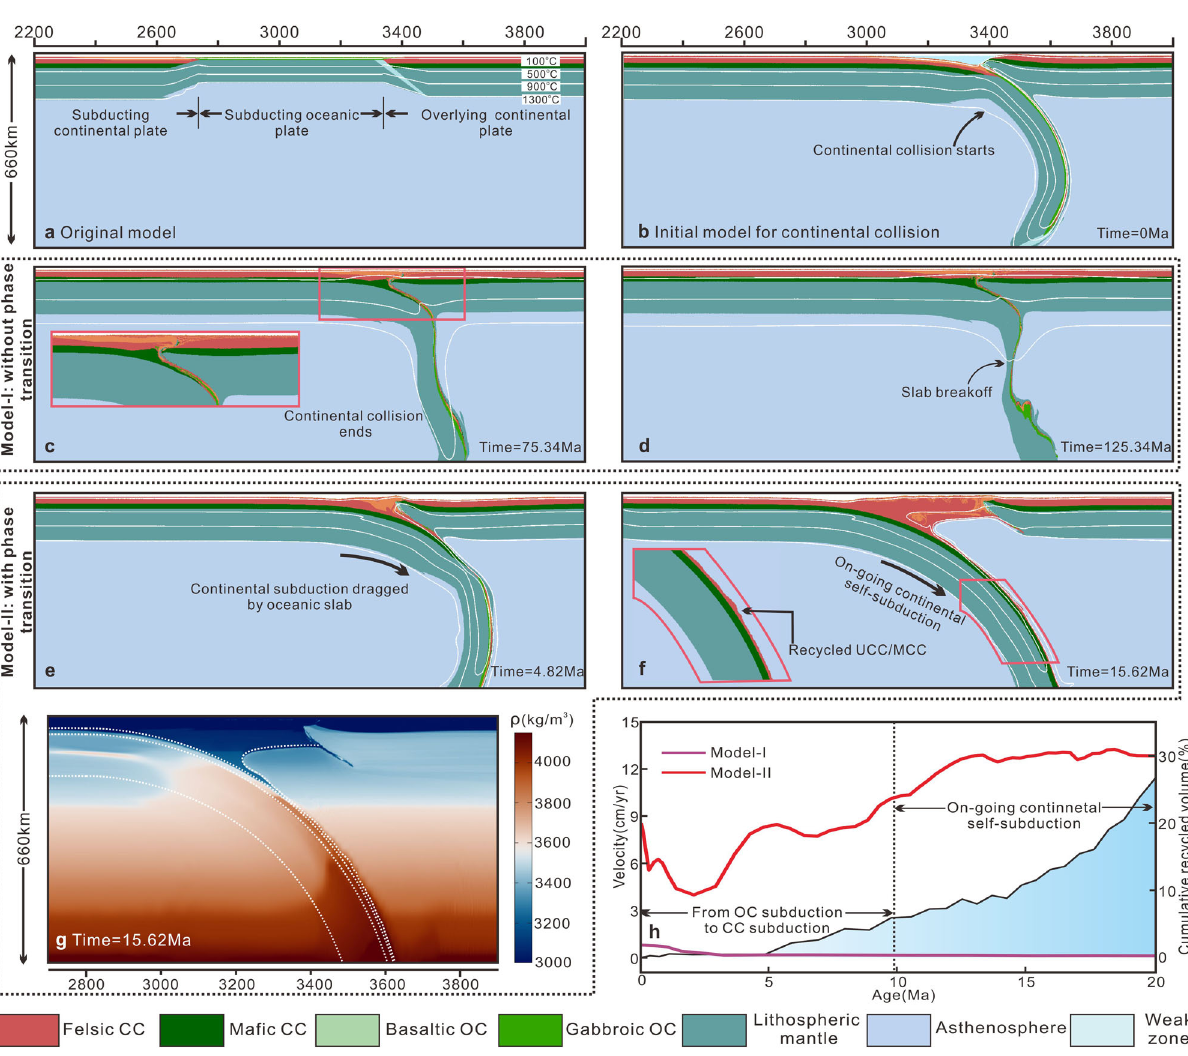
Fig. 2 The model results of continental subduction with two different density evolutions. a Original model con fi guration with a subducting continental plate, an overlying continental plate on both sides and a subducting oceanic plate in between. The subducting plates are pushed internally by a constant velocity of 10 cm/yr for 7 Myrs. b The beginning of continental collision after 7 Myr. This snapshot is used as the initial model for the following study, which is pure density-driven free subduction without any pushing. Two different continental density structures are further applied in Model-I and Model-II. c , d Evolution of Model-I without phase transition. e , f Evolution of Model-II with phase transition and metamorphic densi fi cation. The inset fi gure in f shows the continuous subduction of a part of the felsic crust. g The density structure of continental subduction zone in f . h The convergence velocity evolutions of Model-I and Model-II (left axis) and the accumulated recycled volume of subducted felsic continental crust in Model-II (right